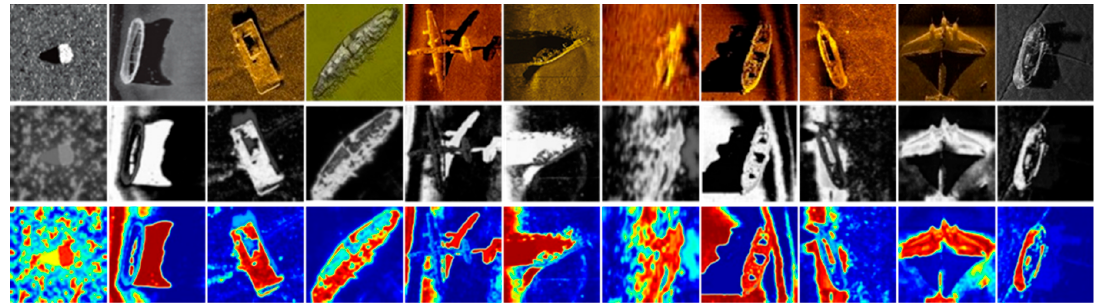
Figure 6. Failure segmentation of the original Lattice Boltzmann method (LBM). The first row: Original sonar images. The second row: Segmentation results of the random initial LBM. The third row: Color images of the second row. It can be seen that using the LBM to segment sonar images directly will lead to wrong segmentation.